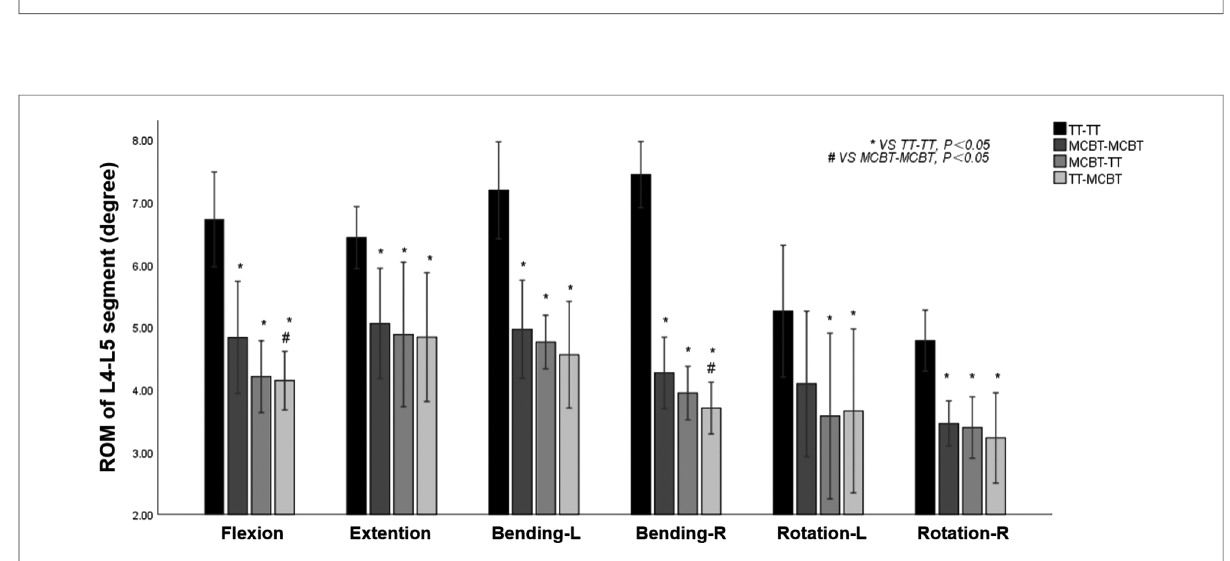
FIGURE 3 Mean values and minimum – maximum ranges of the ROMs of the fi xation segment in four fi xation